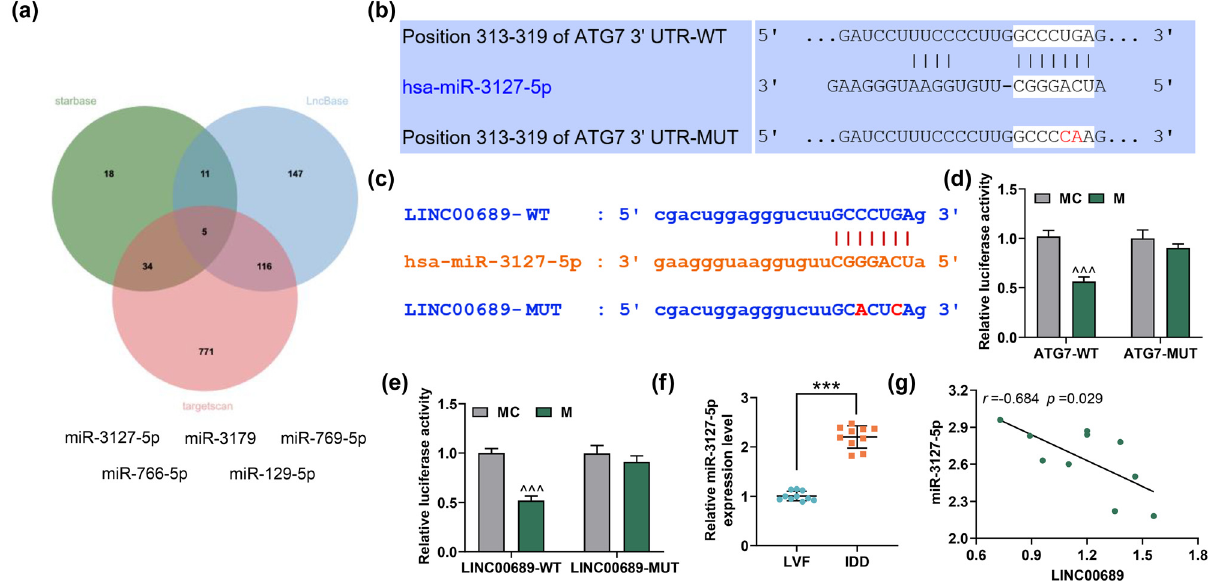
Figure 4: LINC00689 could competitively bind with miR - 3127 - 5p, and ATG7 was targeted by miR - 3127 - 5p in NPCs. ( a ) The upstream miRNAs of ATG7 were predicted by Starbase, TargetScan, and LncBase Predicted v.2 websites. By analyzing the data, fi ve potential upstream miRNAs of ATG7 ( miR - 3127 - 5p, miR - 769 - 5p, miR - 3179, miR - 129 - 5p, and miR - 766 - 5p ) were obtained. ( b ) TargetScan was used to predict the binding site of miR - 3127 - 5p and ATG7. ( c ) The binding site of LINC00689 and miR - 3127 - 5p was predicted via Starbase. ( d and e ) The interrelations of LINC00689, miR - 3127 - 5p, and ATG7 were analyzed using dual - luciferase reporter assay. ( f ) The level of miR - 3127 - 5p in NP tissue samples was measured by qRT - PCR. ( g ) The correlation between miR - 3127 - 5p and LINC00689 levels was analyzed. ^^^ P < 0.001 vs MC; *** P < 0.001 vs LVF ( NPCs: human nucleus pulposus cells, qRT - PCR: quantitative RT - PCR, M: miR - 3127 - 5p mimic, MC: mimic control, LVF: lumbar vertebrae fractures, IDD: intervertebral disc degeneration, ATG7: autophagy related 7, NP: nucleus pulposus )